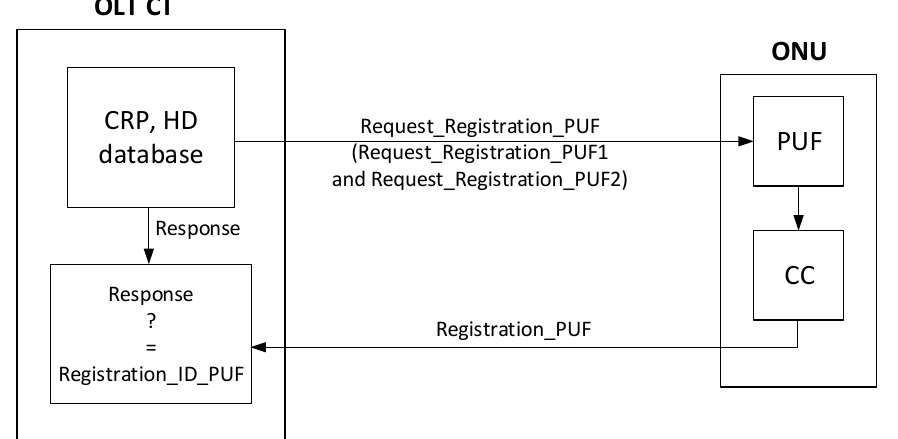
Figure 3. The process of the calculation and verification of the Registration_ID_PUF in